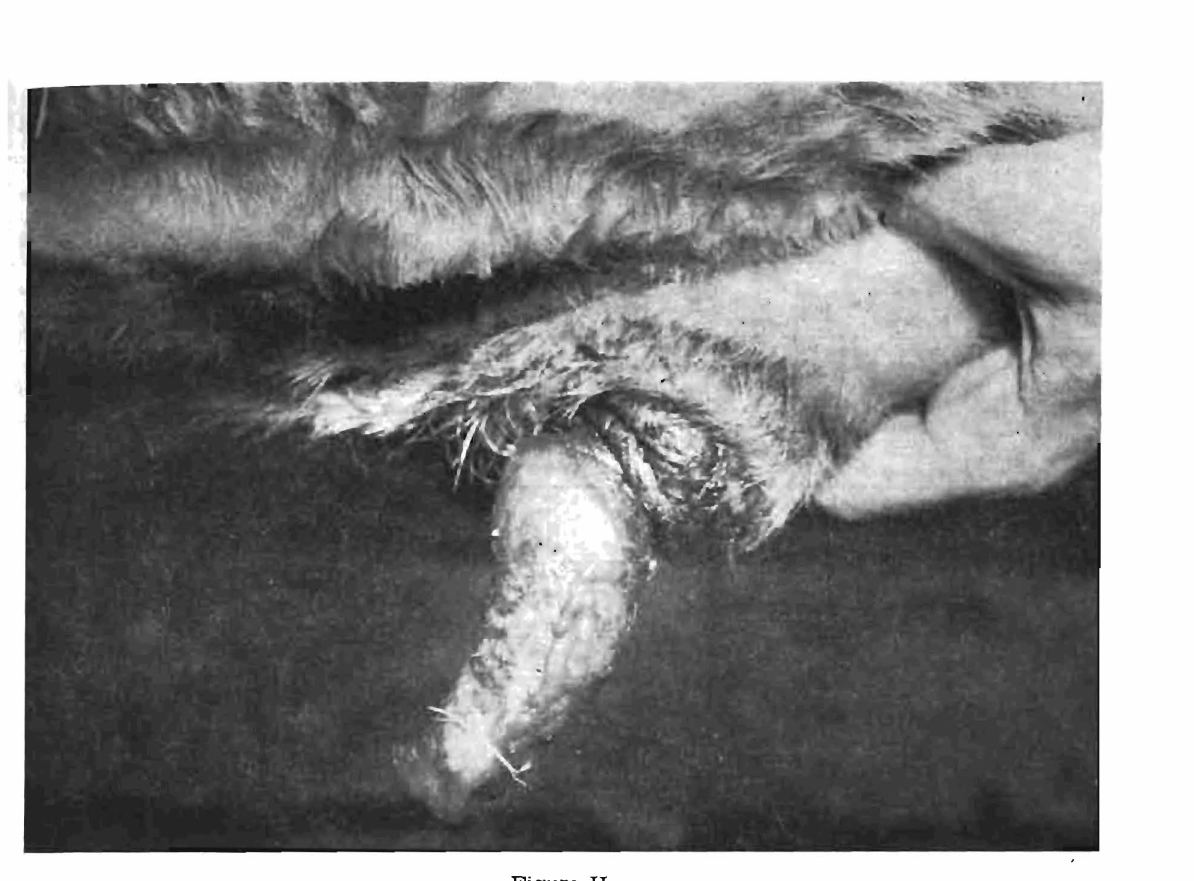
Figure II. Penis of a naturally infected bull showing paraphymoffis and a pseudomembranous